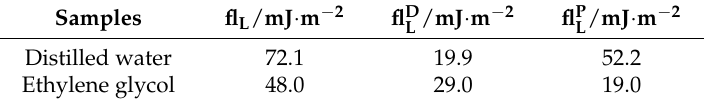
Table 2. Surface energy parameters of test liquids.